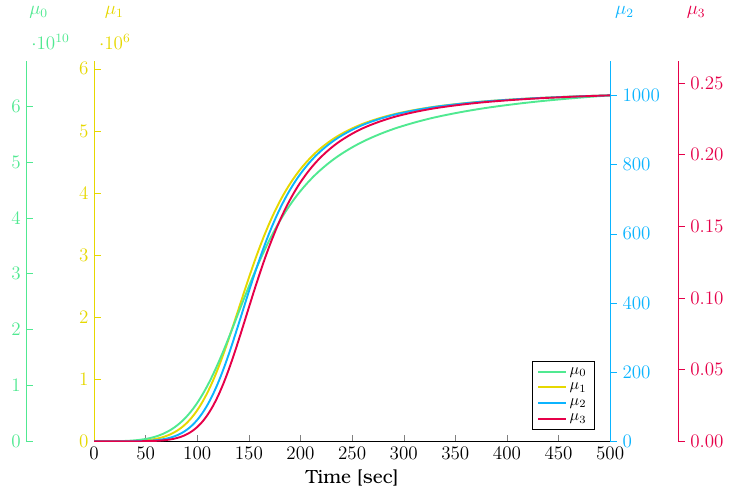
Figure 5. The change in moments ( µ i ) over time, in the case of isothermal batch